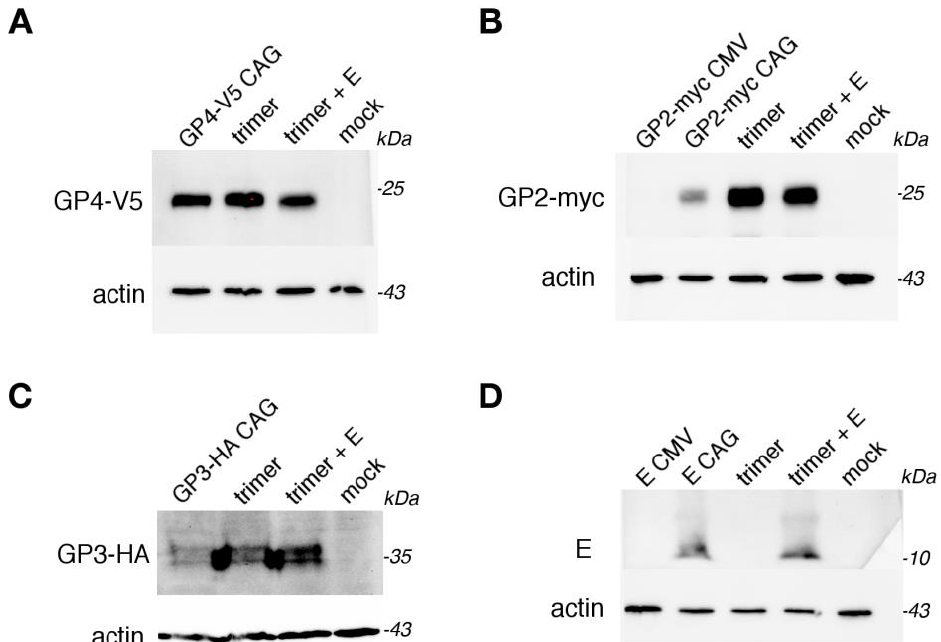
Figure 2. Expression of the components of the EAV spike in BHK-21 cells. BHK-21 cells were transfected with ( A ) GP4-V5 in pACEMam2; ( B ) GP2-myc in pMDC (GP2-myc CMV), GP2-myc in pMDK (GP2-myc CAG); ( C ) GP3-HA in pMDS (GP3-HA); ( D ) plasmid encoding E in pML-DAZ2 E CMV, plasmid encoding E in pMDK (CAG), or were transfected with plasmid pGP2/GP3/GP4 (trimer) or co-transfected with pGP2/GP3/GP4 and E in pMDK (trimer +E). Twenty-two hours after transfection, cells were lysed and samples subjected to SDS-PAGE and Western blotting with anti-V5 antibody ( A ), anti-myc antibody ( B ), anti-HA antibody ( C ), or anti-E antibody ( D ). Blots were cut and probed with anti-actin antibody as a loading control ( A , B , D ), or in ( C ) the blot membrane, were stripped and re-probed with anti-actin antibody. Molecular weight markers are given on the right-hand side. Mock: untransfected